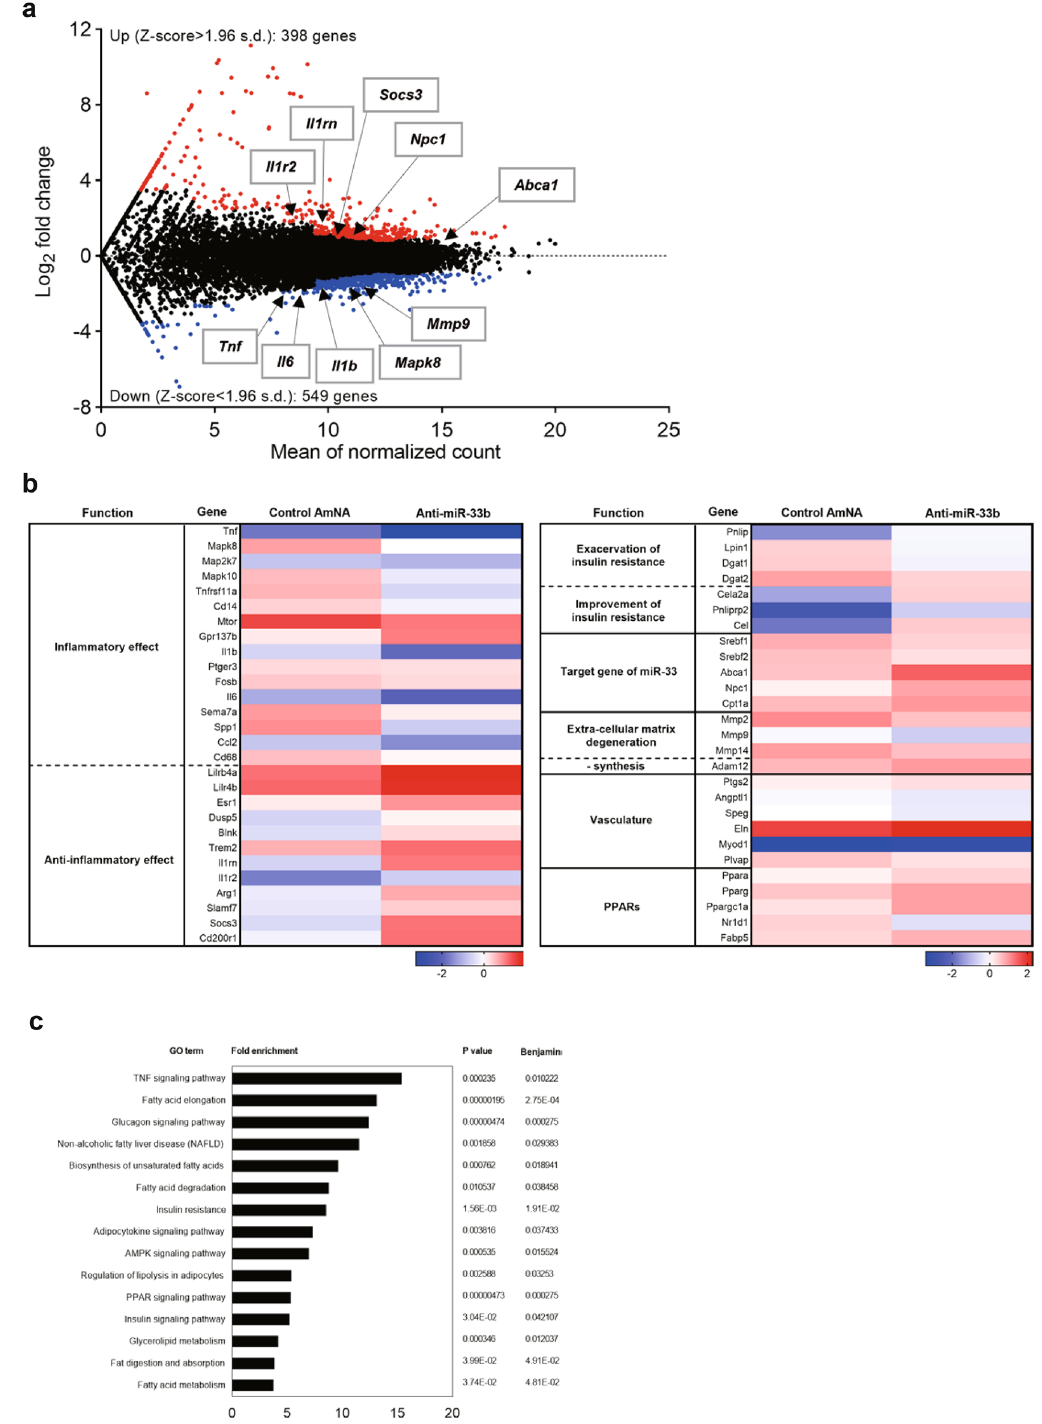
Figure 8. RNA-seq analysis for CaCl 2 -induced AAA samples of AMO-administered miR-33b KI mice and anti- miR-33b working hypothesis. ( a ) MA plot illustrating the number of differentially expressed genes. Red dots: upregulated genes; blue dots: downregulated genes, as determined by log 2 (fold change) between anti-miR-33b and control AmNA administered CaCl 2 -induced AAA samples of miR-33b KI mice. ( b ) Heatmap representation of normalized gene expressions as intensity-based Z-score. ( c ) Enrichment analyses of integrated pathways for anti-miR-33b injected AAA miR-33b KI mice. ( d ) Schematic diagram of the effects of